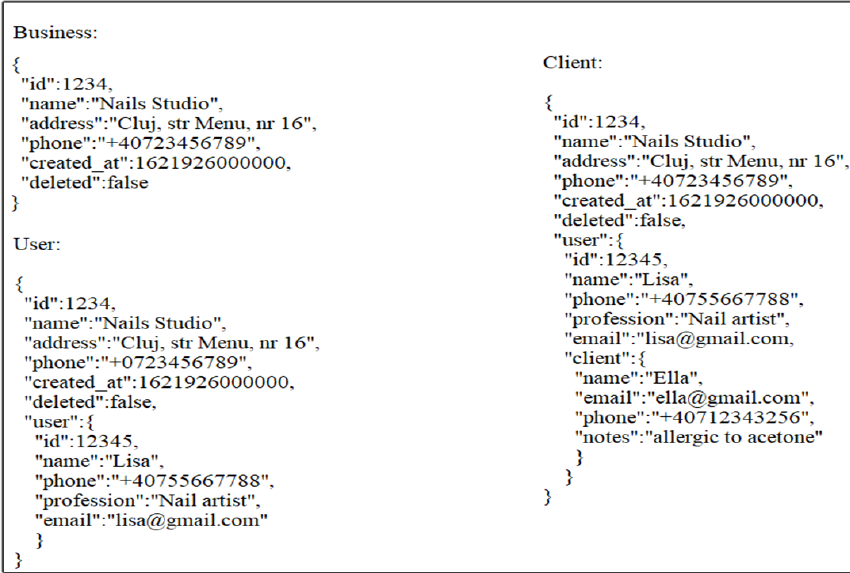
Figure 2. Document-based MySQL structure.